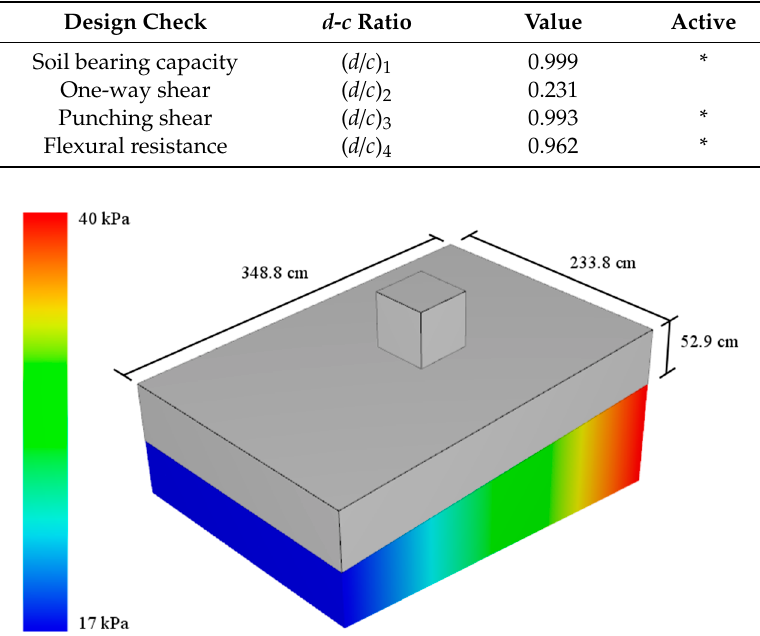
Figure 9. Example 1: Geometry and pressure distribution (service combination) of the obtained optimum design.